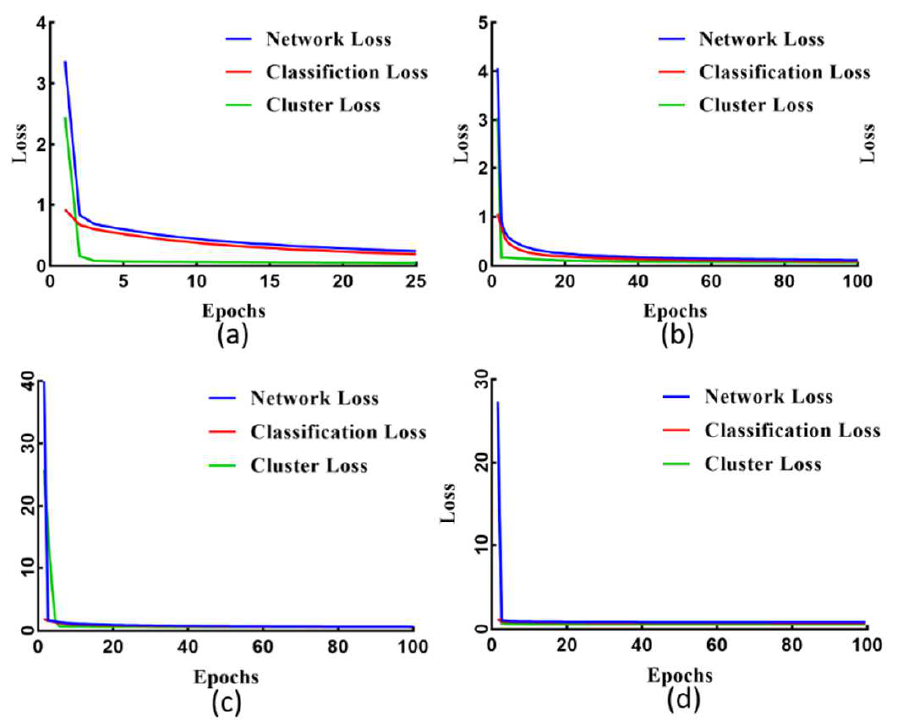
Figure 13. Convergence curve of STT for different datasets. ( a ) Yancheng dataset, ( b ) Hermiston dataset, ( c ) River dataset, ( d ) Bay Area dataset. Table 4. Execution time of various methods using different experimental datasets (seconds). Table 3. Ablation study: STT with 5-dimensional vs. 3-dimensional input patches. Methods